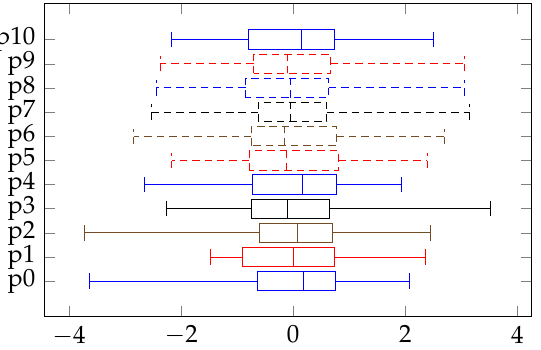
Figure 4. Statistical information of normalized sensor readings of barrel